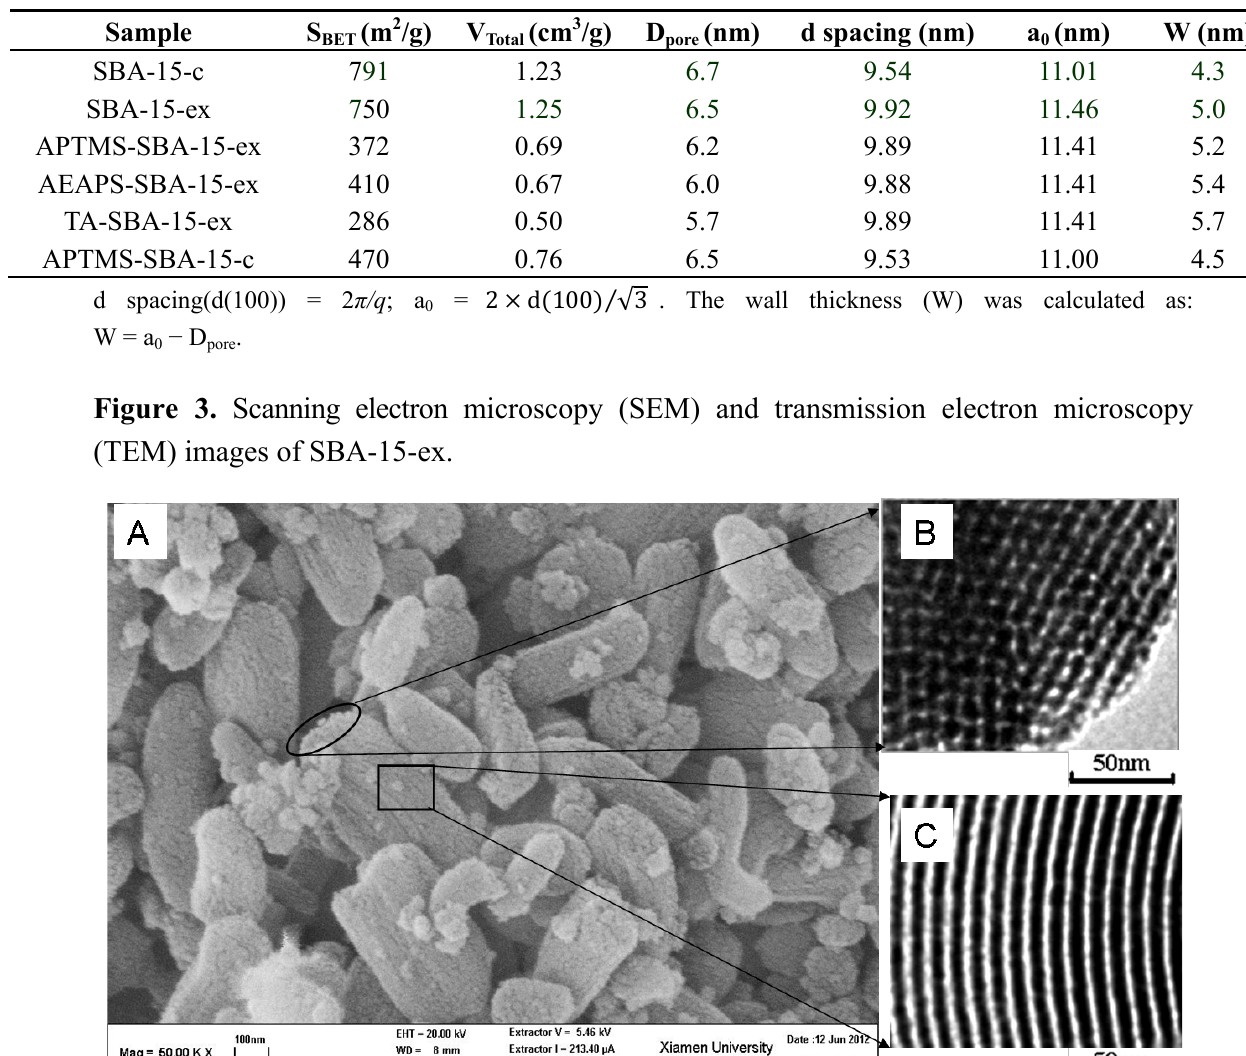
Table 1. The textural parameters of SBA-15 and amine-grafted SBA-15.